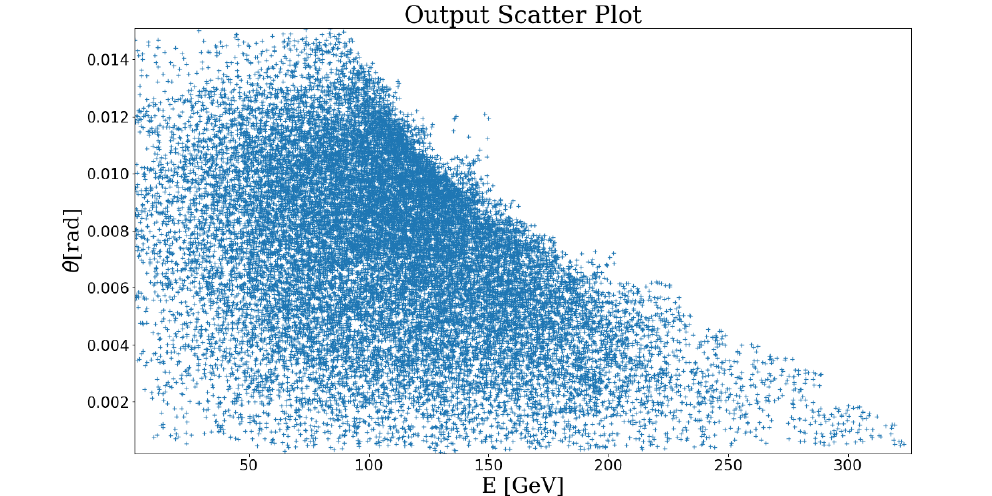
Figure 5. Re-generated 2D-scatter plot starting from the (cid:12)tted 2D-mesh. See (cid:12)gure 3 for the comparison with the original